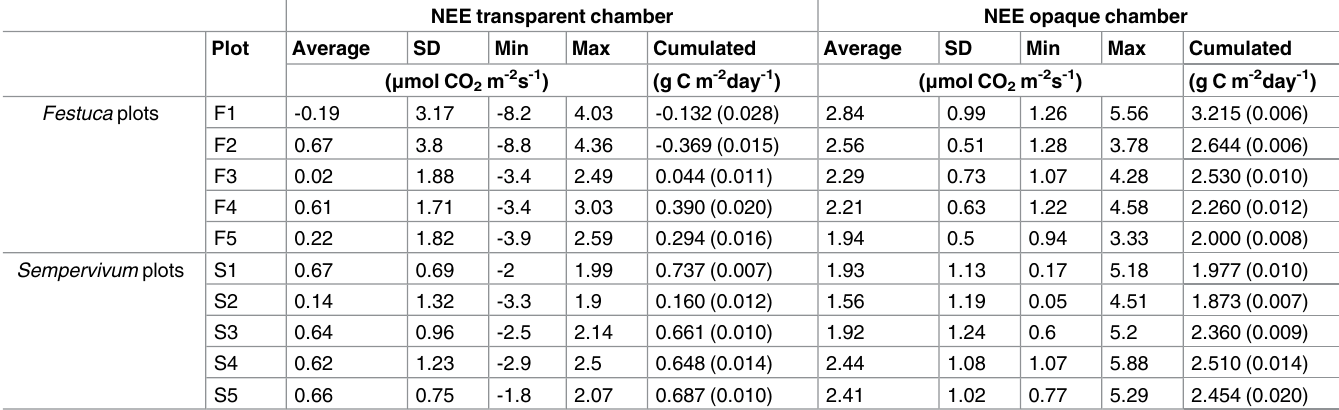
Table 2. Characterization of NEE fluxes measuredfor each plot with dark and clear chambersin